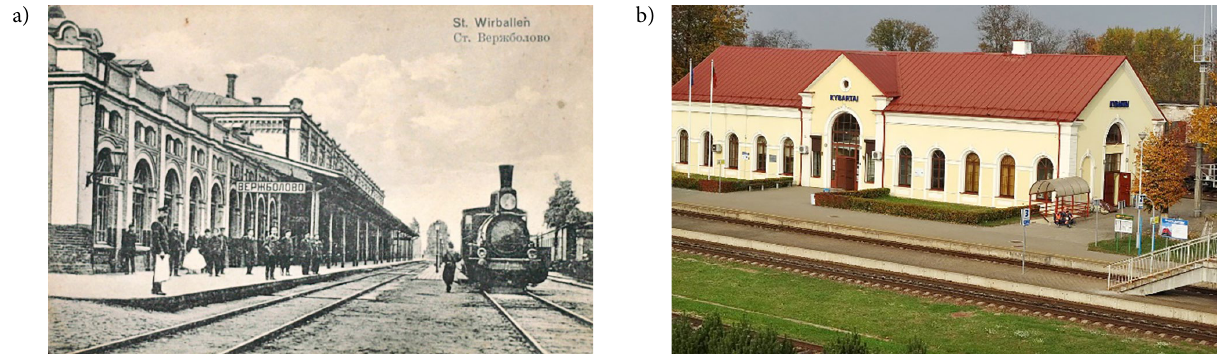
Figure 3. Railway station: a – Virbalis railway station at the juncture of the 19 and 20th centuries (Mickevičius 2007);